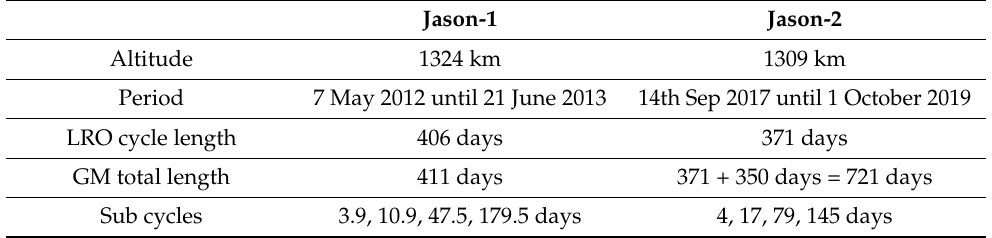
Table 1. Orbital characteristics of the Long Repeat Orbit (LRO) of Jason-1 and Jason-2